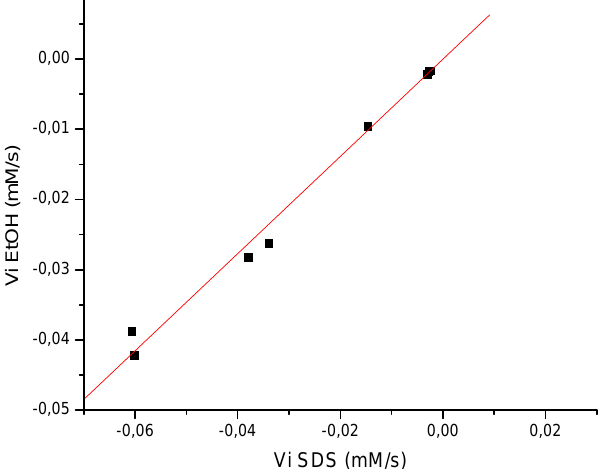
Vi: initial rate; ■ : initial rate values obtained from reaction in ethanolic solution and micelar phase of the compounds 3 - 5